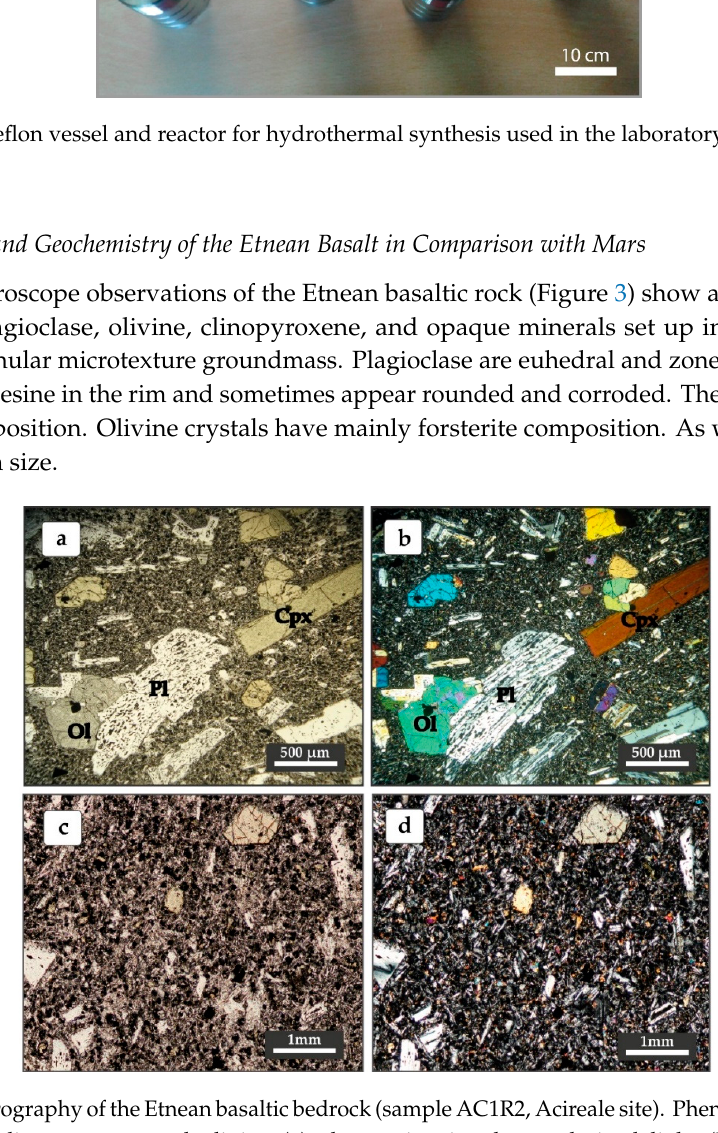
Figure 2. Teflon vessel and reactor for hydrothermal synthesis used in the laboratory experiment.